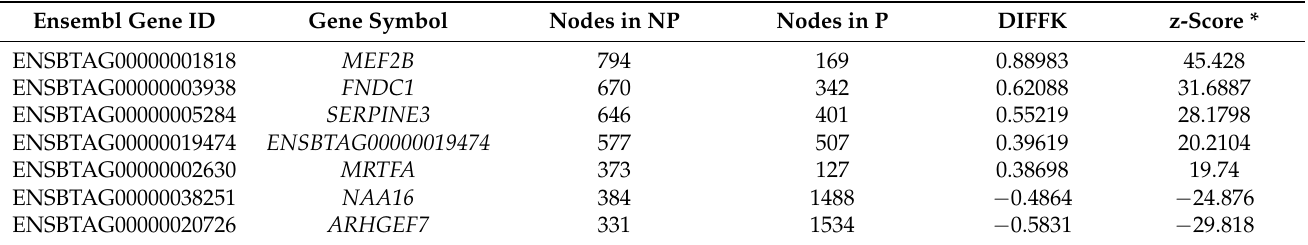
Table 1. Uterine luminal epithelial differentially connected genes between pregnant (P) and non- pregnant (NP)